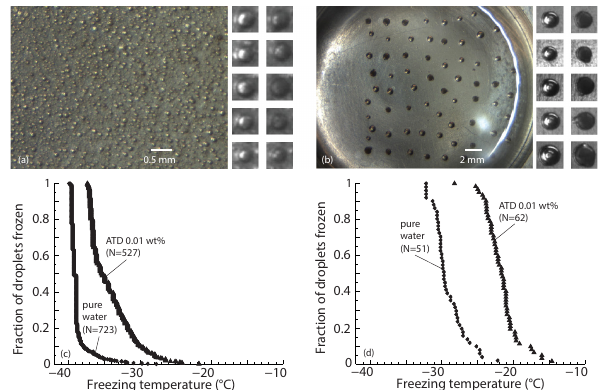
Figure 1. (a) A section of the field of view for a picodrop exper- iment. The small images to the right depict enlarged examples of individual picodrops prior to freezing (left column) and after freez- ing (right column). (b) Field of view recorded for a nanodrop exper- iment; the columns to the right are similar to those in (a) . (c, d) Frac- tion of droplets frozen versus temperature for picodrop and nan- odrop experiments, respectively, of both pure water and a 0.01wt% suspension of ATD.